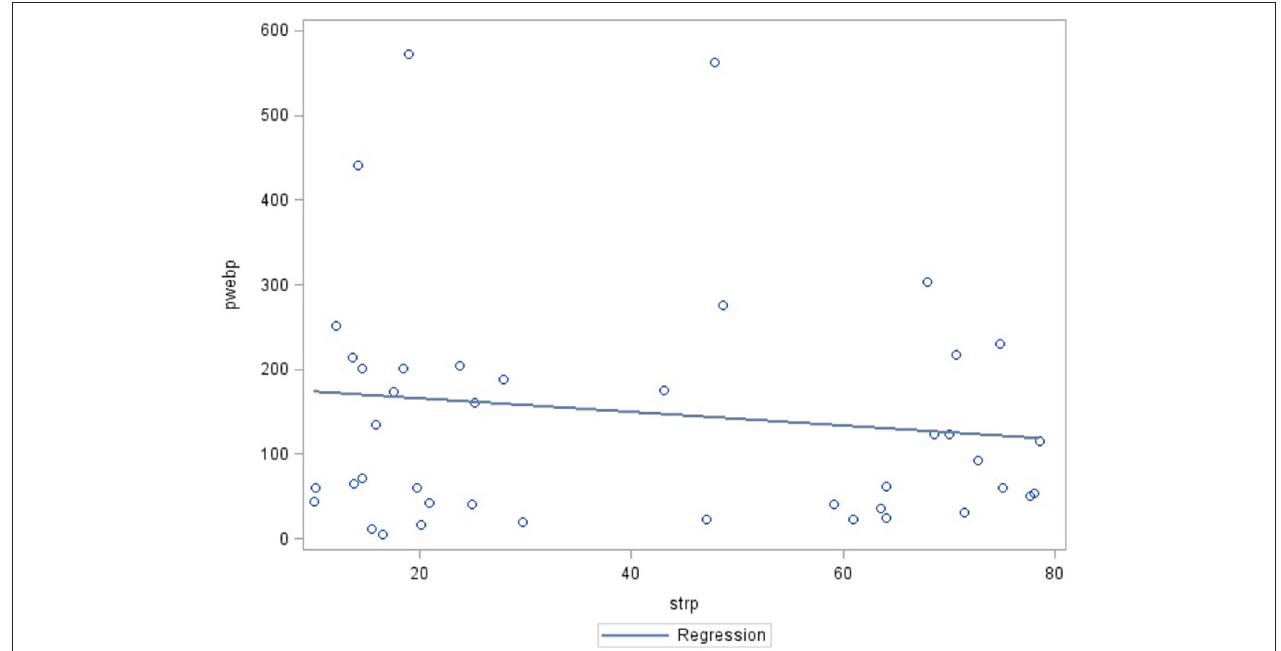
FIGURE 1 | Relevant scatter plot between city-level number of subscribers of internet and severe mental afters